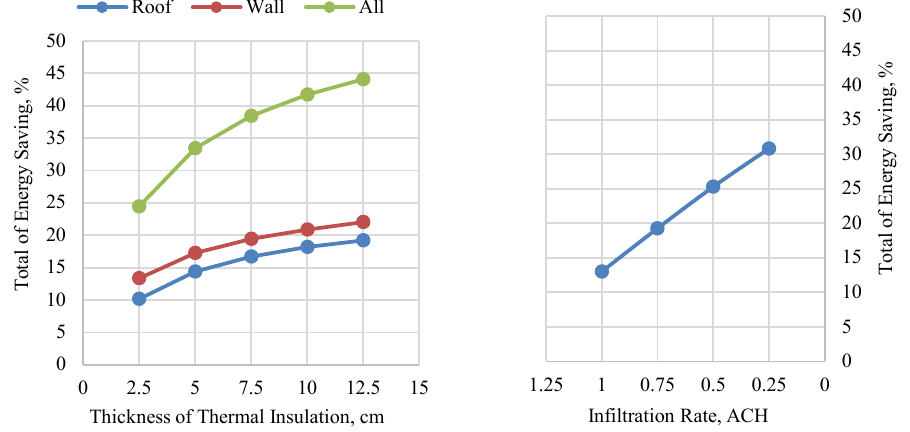
Fig. 5. Annual energy saving present from insulation (left) and infiltration rate (right) in climate zone 1.